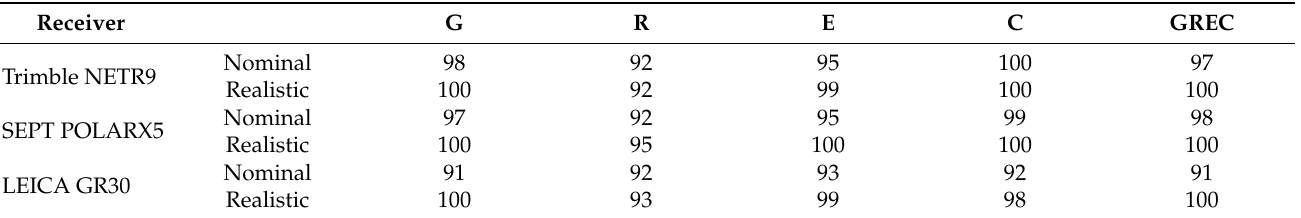
Table 8. Estimated empirical success rate (SR) with Nominal and Realistic stochastic model in % (G:GPS, E:Galileo, R:GLONASS,